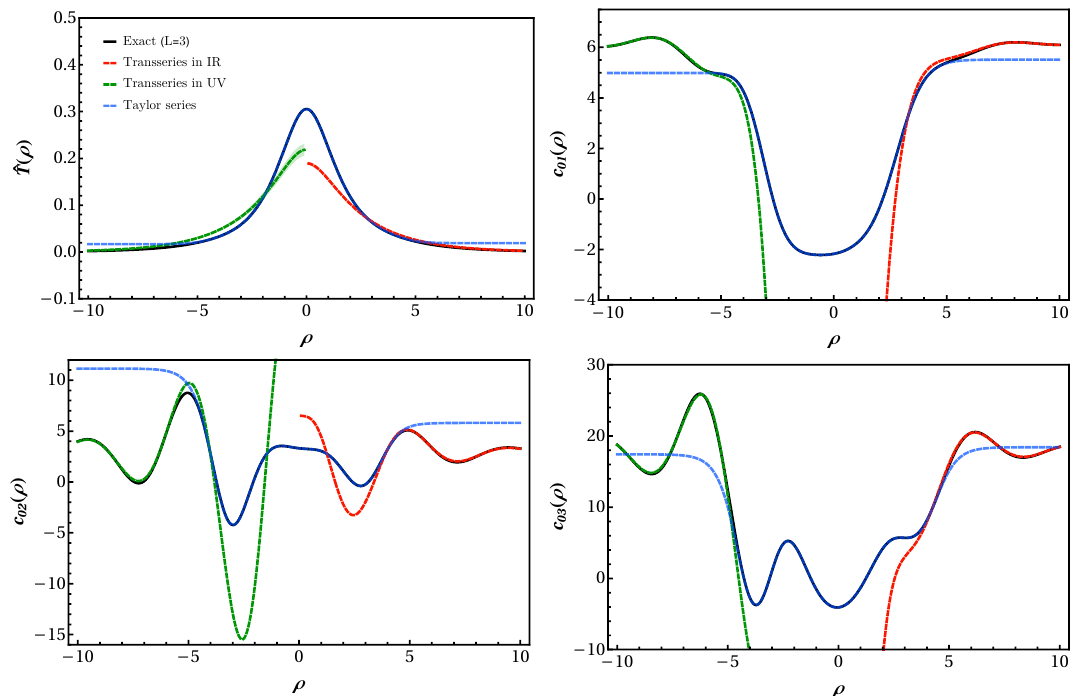
Figure 5. Construction of transseries around the UV (cid:12)xed point (green dashed line) and IR (cid:12)xed point (red dashed line) compared to the exact numerical solution (black). The exact solution is computed by setting (cid:18) 0 = 25 = 2 (cid:25); c 01 ( (cid:26) 0 ) = 6 : 1744 ; c 02 ( (cid:26) 0 ) = 1 : 6959 ; c 03 ( (cid:26) 0 ) = 17 : 492 ; T ( (cid:26) 0 ) = 0 : 0014, where the initial time is set to (cid:26) 0 = (cid:0) 10. The transseries is computed by using (cid:12)rst- order non-perturbative corrections and including up to 30th-order perturbative terms around the (cid:12)xed points. Their integration constants are calculated by simultaneous least-square data-(cid:12)tting technique using the data of exact solution. Moreover, we have computed the Taylor expansion at (cid:26) = 0 up to 10000th